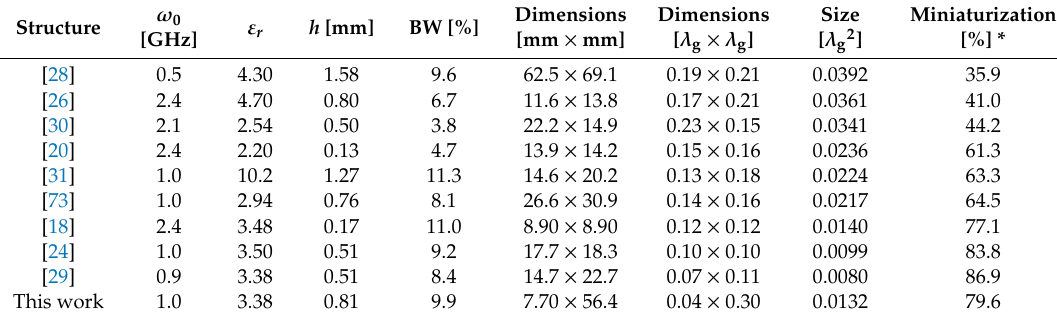
Table 7. Comparison of coupler BA(3,1) with benchmark